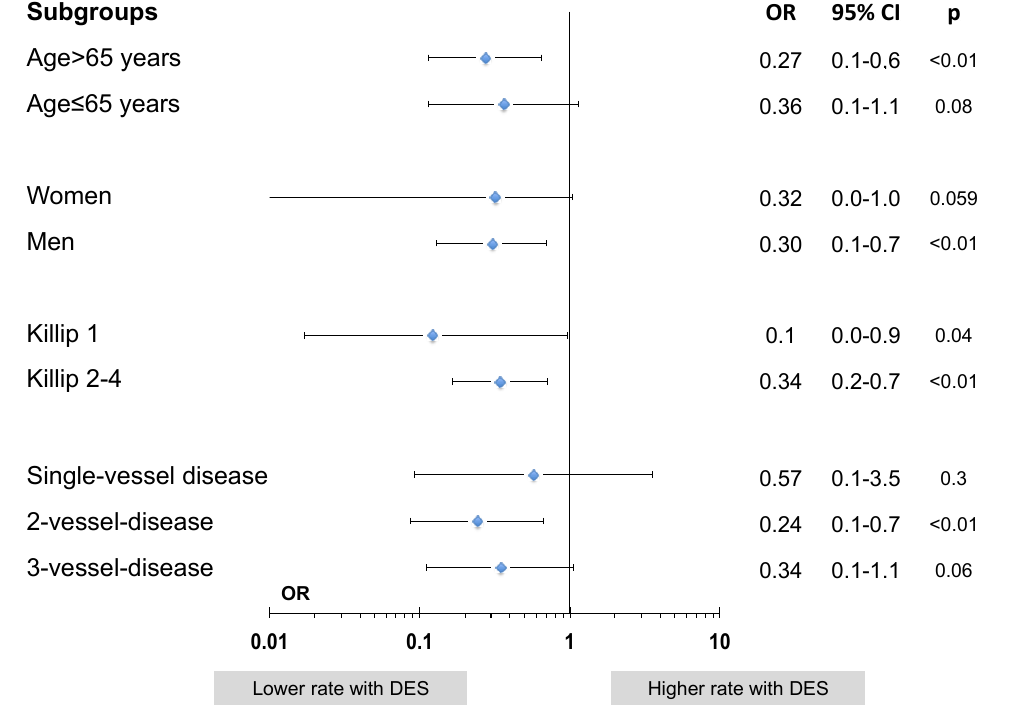
Figure 3. Subgroup analysis of cumulative ischemic event rates in DES vs. BMS: Multivariate model analysis for subgroups with stent type adjusted for age, gender, cardiogenic shock, anterior STEMI, type and duration of P2Y12-inhibitor and number of stents implanted.